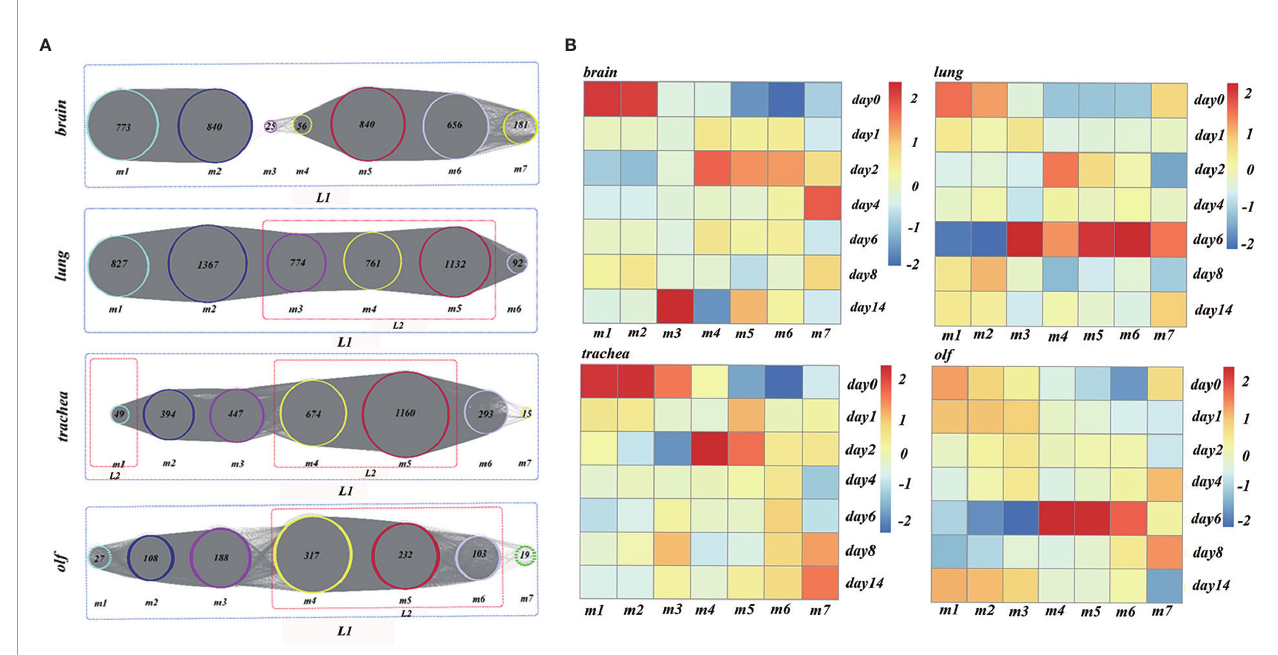
FIGURE 4 | (A) The analysis results of time-order gene modules in different organs. L1 represents the body ’ s stress response, whereas L2 represents the immune response mediated by the immune cells. (B) Heatmaps of the average normalized counts per million (CPMs) in different